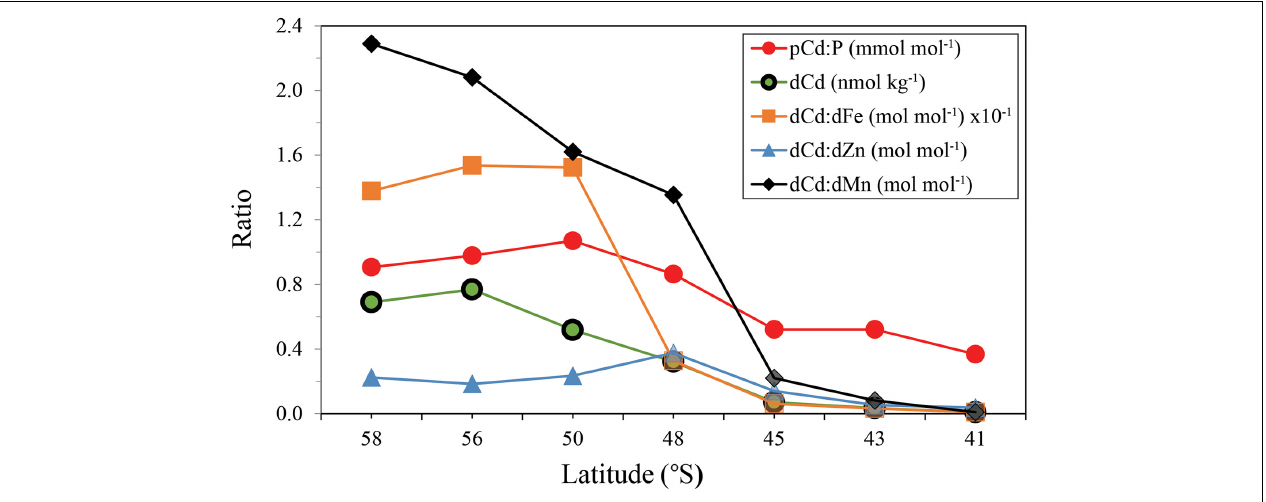
FIGURE 5 | Plot of dCd and pCd:P, dCd:dFe; dCd:dZn, and dCd:dMn spot ratios for surface waters ( ∼ 25 m) across the transect. Note: where necessary units were converted to plot on a single vertical axis for direct